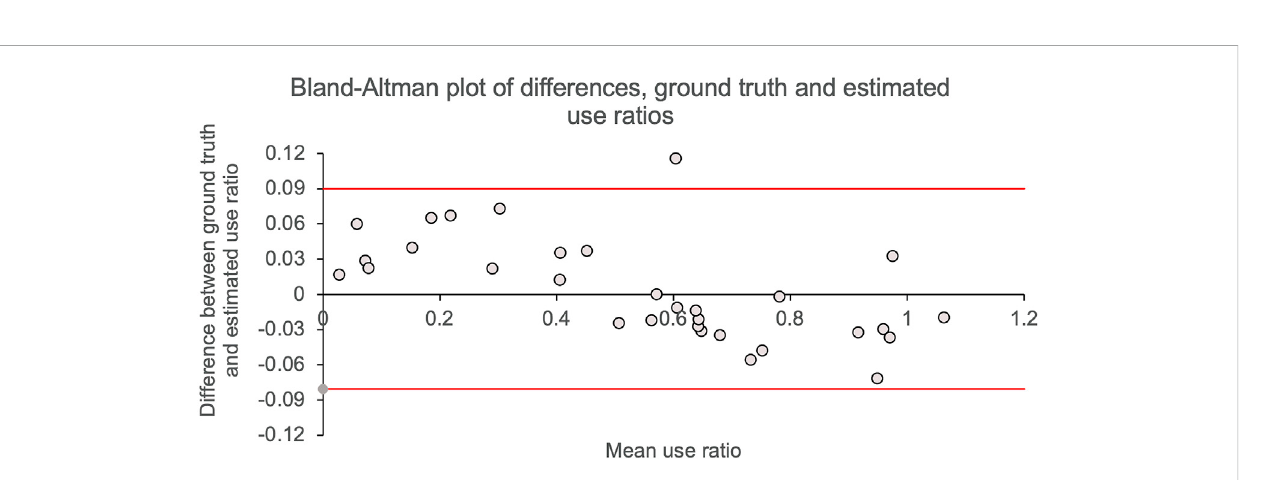
Table 3. Principal component and varimax rotated factor loadings for 1- and 2-factor solutions. High factor loadings (large contribution > 0.6) (Reyment, 1996) are shown in bold numbers.